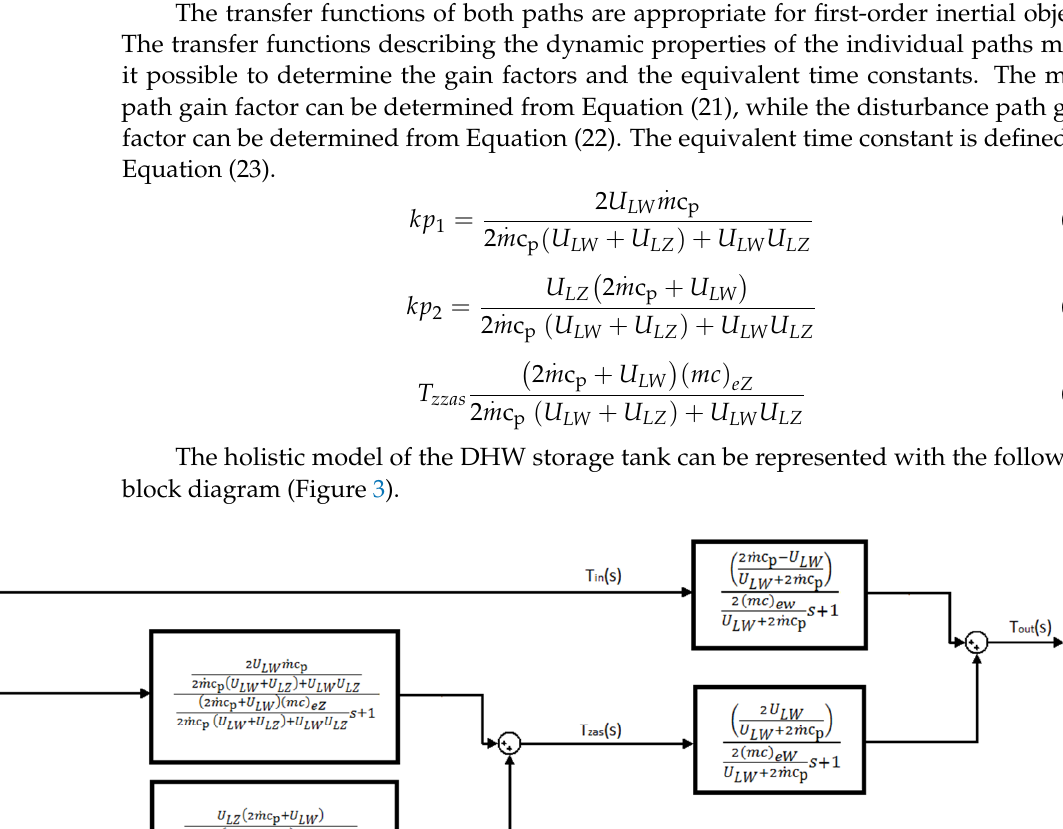
Figure 3. Block diagram of the DHW storage tank.